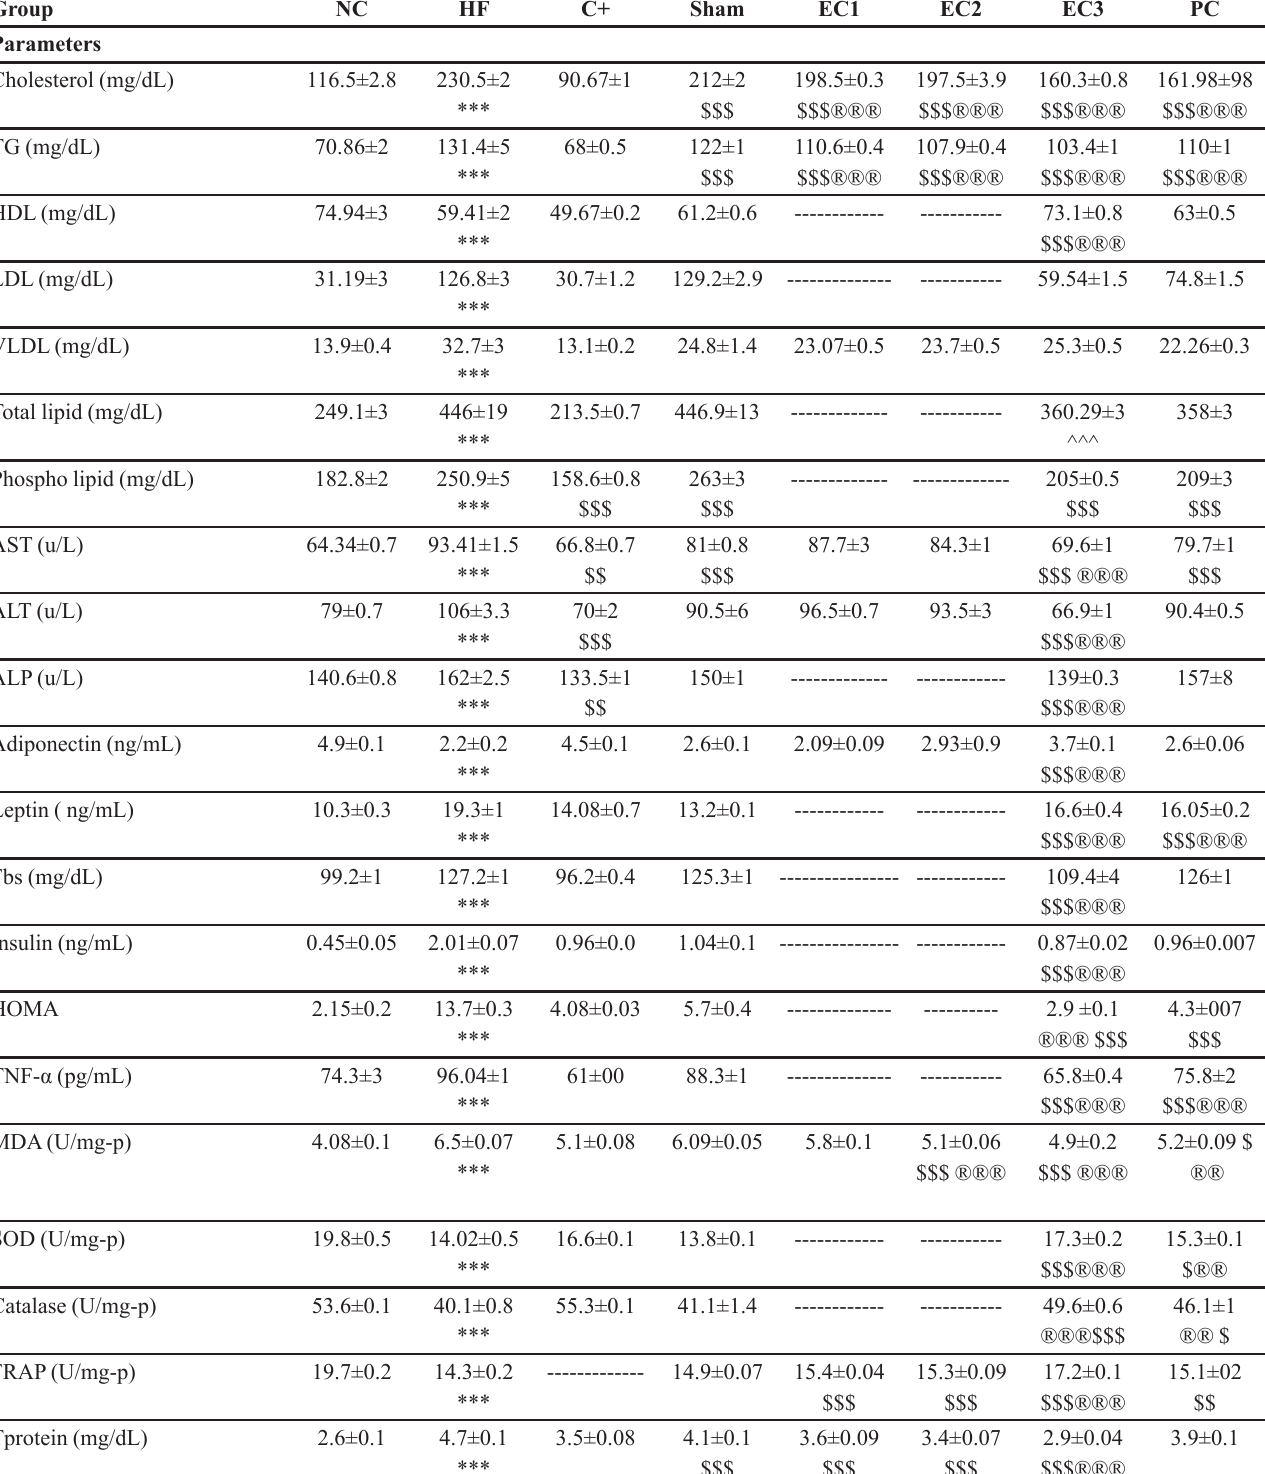
TABLE IV - Effect of citral on biochemical indices and antioxidant enzymes in mice treated with high fat emulsion. Data are expressed as mean±SEM. *** p<0.001compared with NC (Normal control),$$$p<0.001 compared with HF, ®®® p<0.001 compared with sham, $$ p<0.01 compared with HF, ®® p<0.01 compared with sham, $ p<0.05 compared with HF(high fat), ® p<0.05 compared with